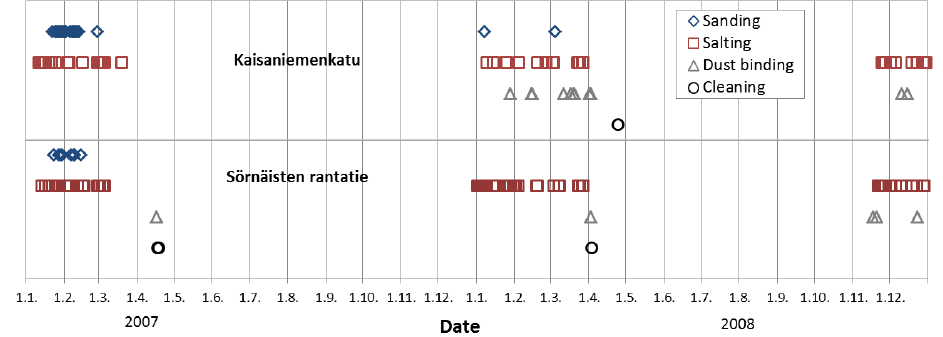
Figure 2. The dates of traction control and street maintenance measures in Kaisaniemenkatu (upper panel) and Sörnäisten rantatie (lower panel) in 2007 and 2008. The figure presents dates of sanding (blue diamonds), salting (red squares), dust binding (grey triangles) and street cleaning (black